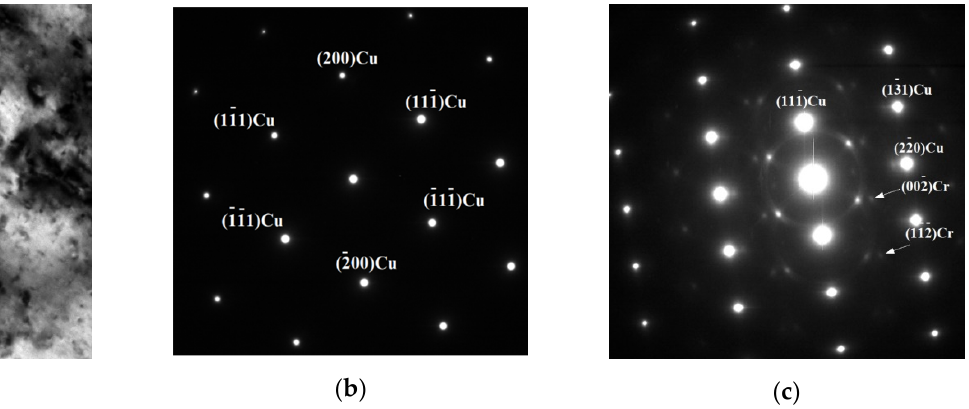
Figure 13. Bright-field TEM image of Cr50WC50 ( a ) SAED pattern from the [011] fcc Cu zone axis ( b ), SAED pattern from the [112] fcc Cu zone axis showing extra reflections from the ordered bcc Cr rich (the N–W relationship) ( c ).